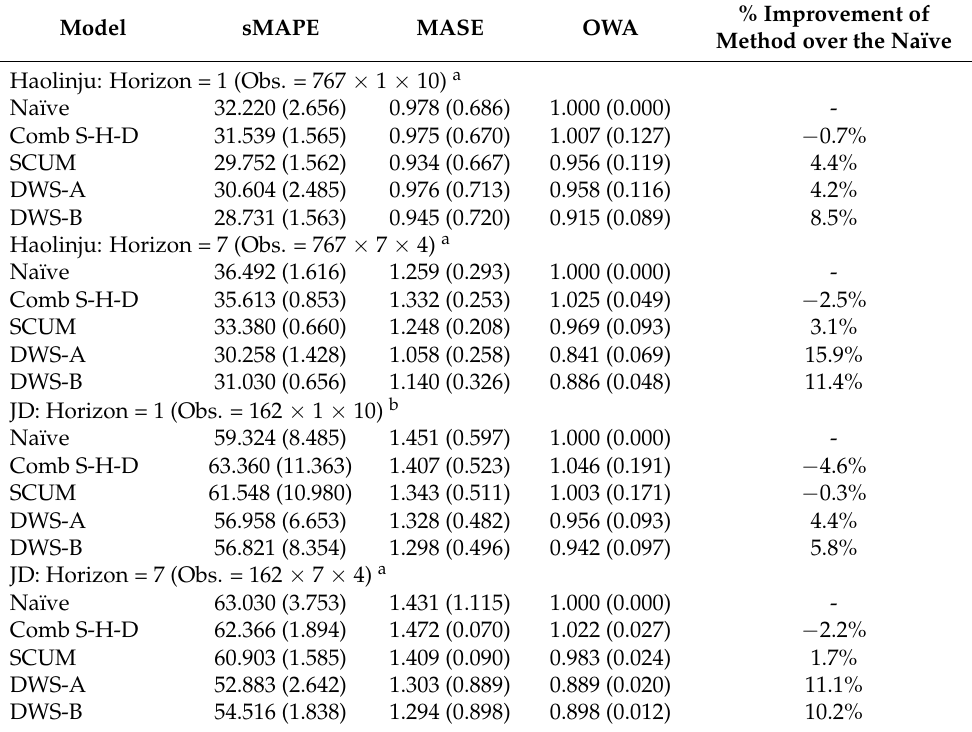
Table 5. The performance of the five methods for rolling forecast testing in the erratic